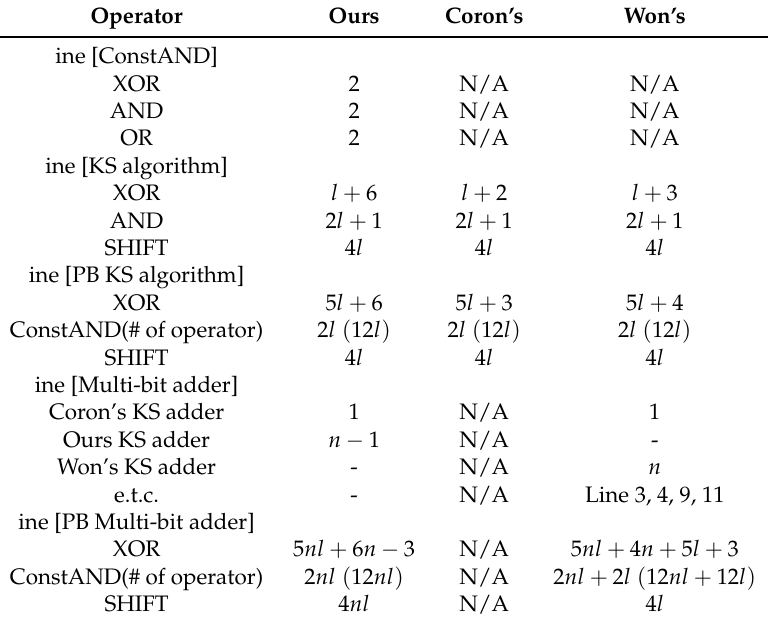
Table 6. Comparison of the total number of operations.